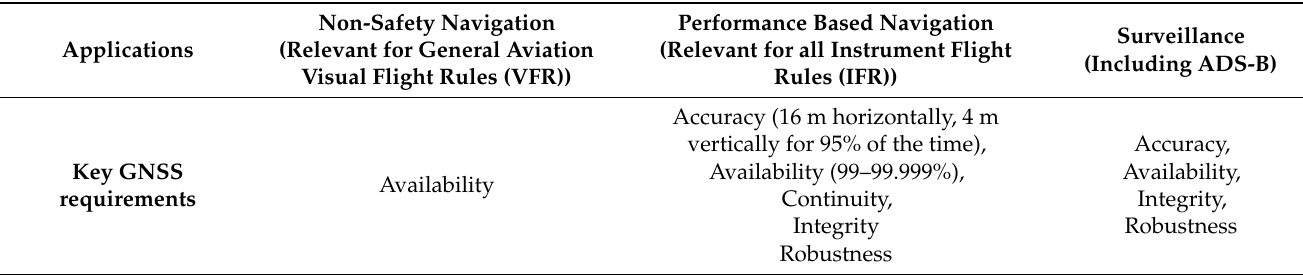
Table 1. Key requirements for the aeronautics